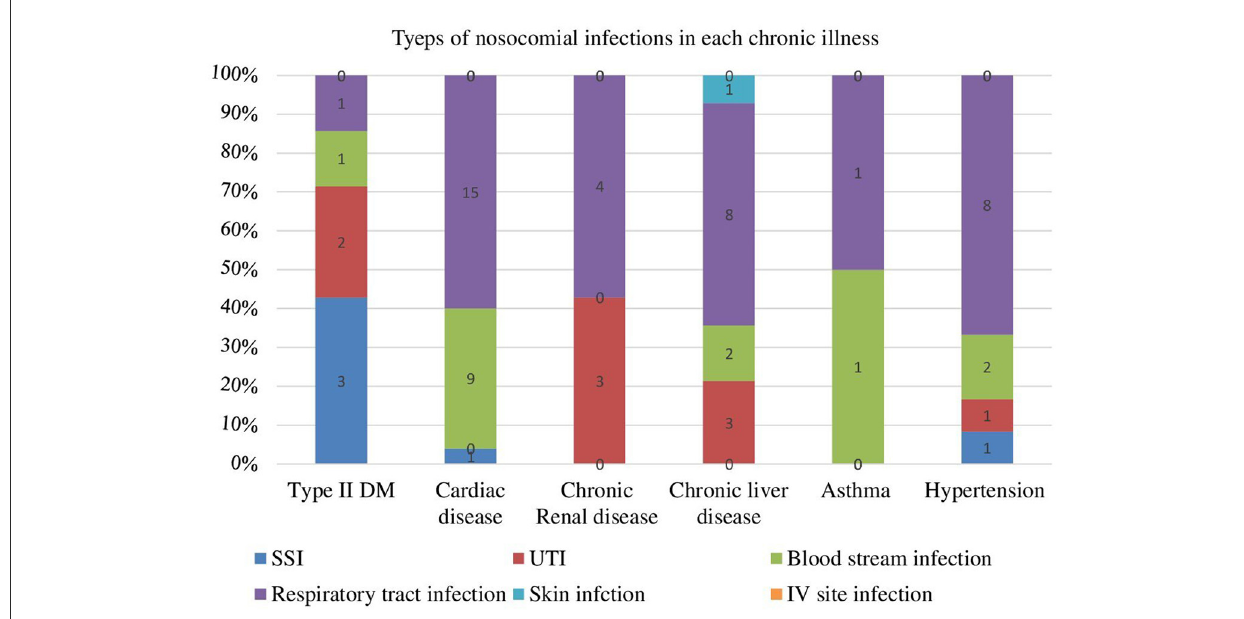
FIGURE1 Types of nosocomial infection among chronic illness patients at University of Gondar Comprehensive Specialized Hospital Northwest Ethiopia from 2016–2020 ( N = 53).